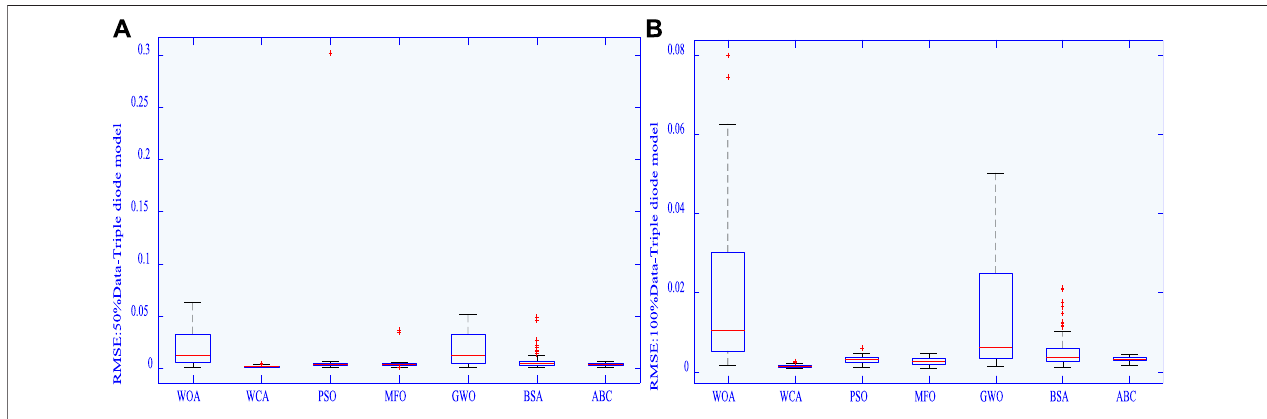
Frontiers in Energy Research |